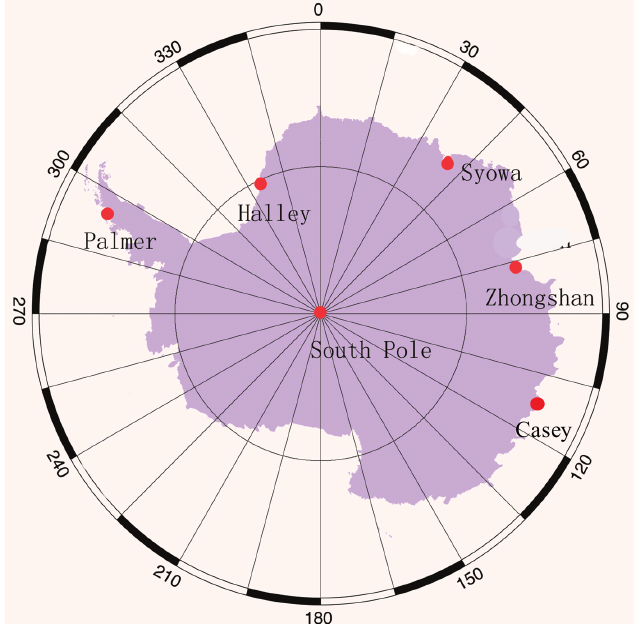
Figure 1. The location of other CO Zhongshan